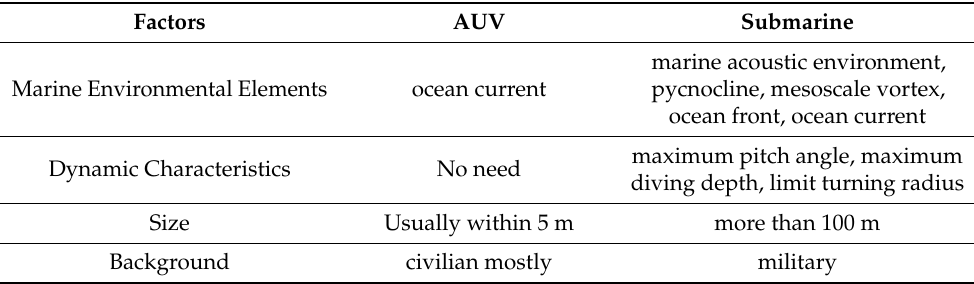
Table 2. The Difference between AUV and